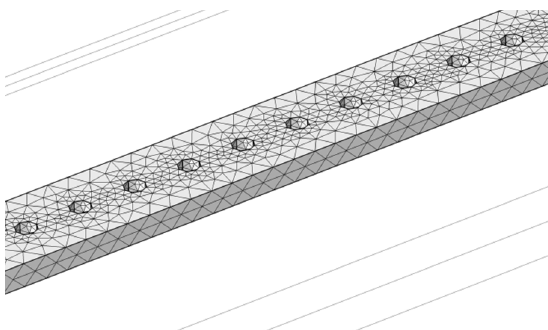
Figure 3. Meshing employed for the finite element analysis of the resonant frequency of SiCN nanostrings of length L = 15  m, width W = 200 nm and thickness t = 50 nm. The strings are milled with linear array of holes of diameter D = 45 nm and center-to-center spacing s = 120 nm The figure shows a 1.2 m long segment of the string. The meshing of the whole string employed a total of 92,243 tetrahedral